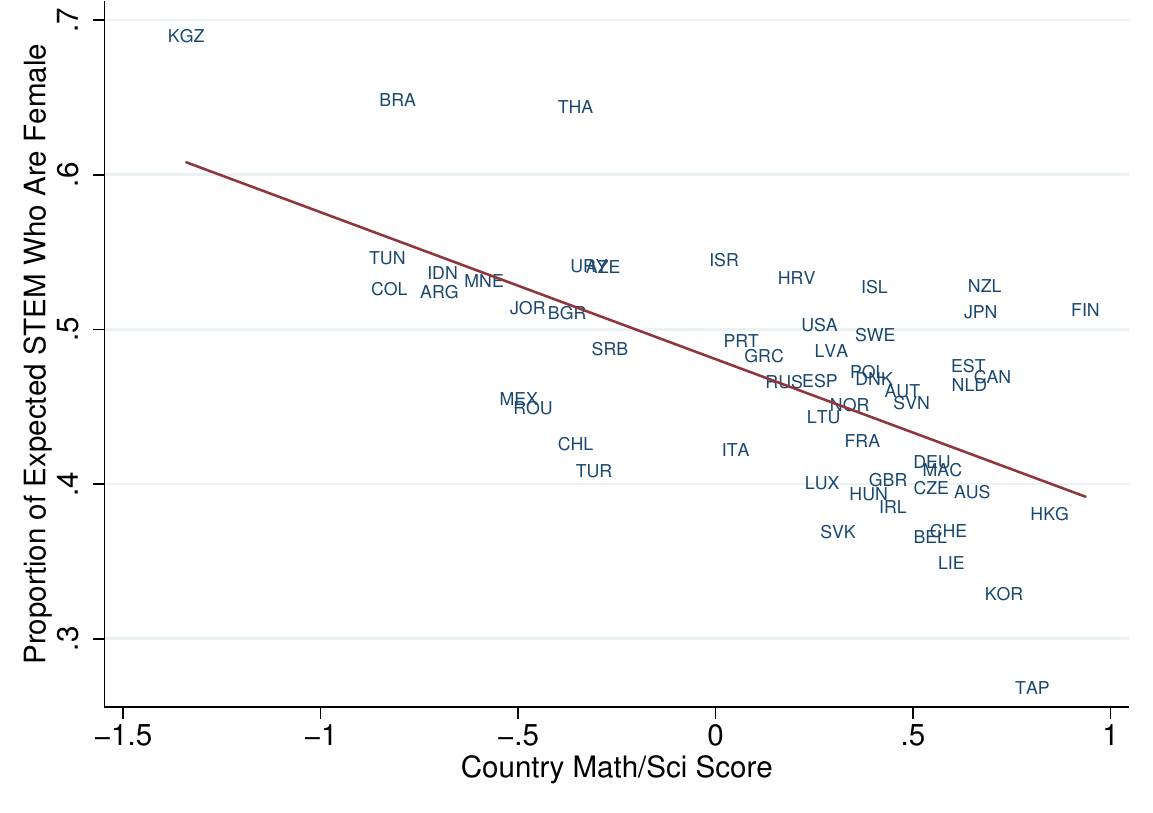
Figure 9: Relationship between the proportion of girls among expected STEM students and the national math-science performance